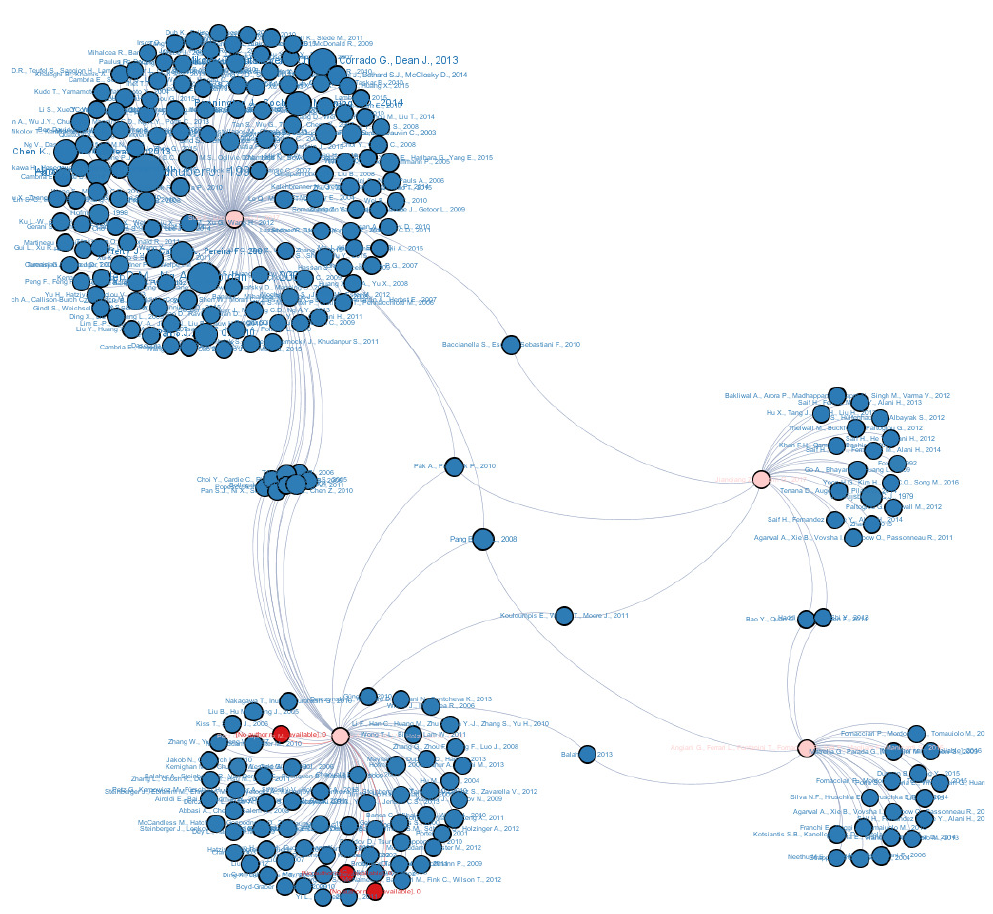
Figure A1. Citation